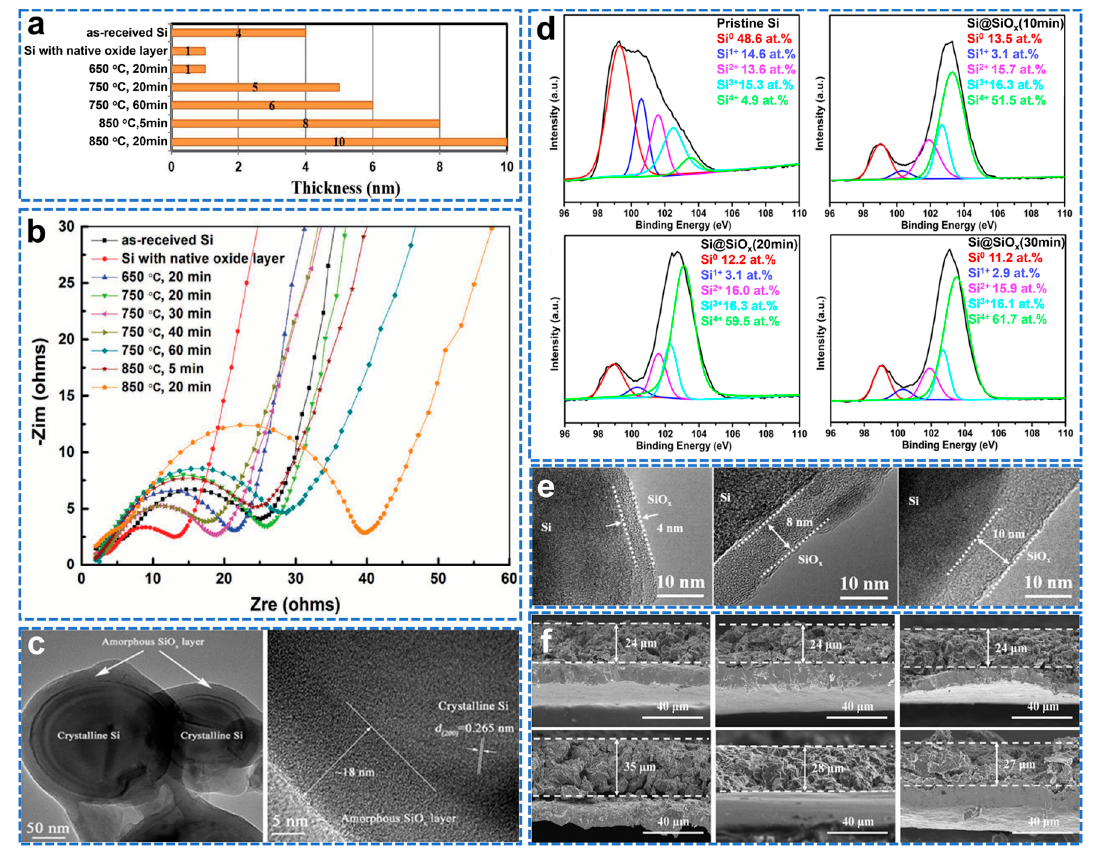
Figure 16. ( a ) Comparison of thickness of the thermally grown oxide layers under different oxidation conditions, ( b ) Electrochemical impedance spectroscopy (EIS) curves after de − lithiation in the second cycle [143]. ( c ) TEM image and HRTEM image for Si@SiO x (20 min) sample, ( d ) High resolution XPS spectra of Si 2p for pristine Si, Si@SiO x (10 min), Si@SiO x (20 min), and Si@SiO x (30 min) samples [144]. ( e ) TEM images of Si − 9 h, Si − 11 h, and Si − 13 h, ( f ) Cross − sectionals before and after 200 cycles of GSC − 9 h, GSC − 11 h, and GSC − 13 h electrodes [145].